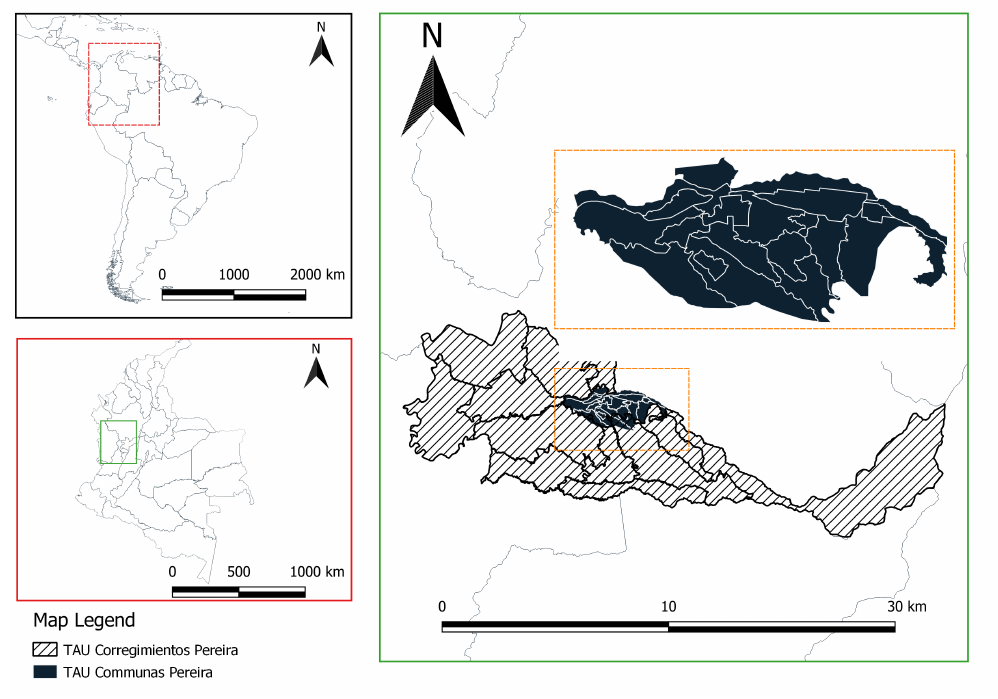
Figure 1. Location of Pereira.